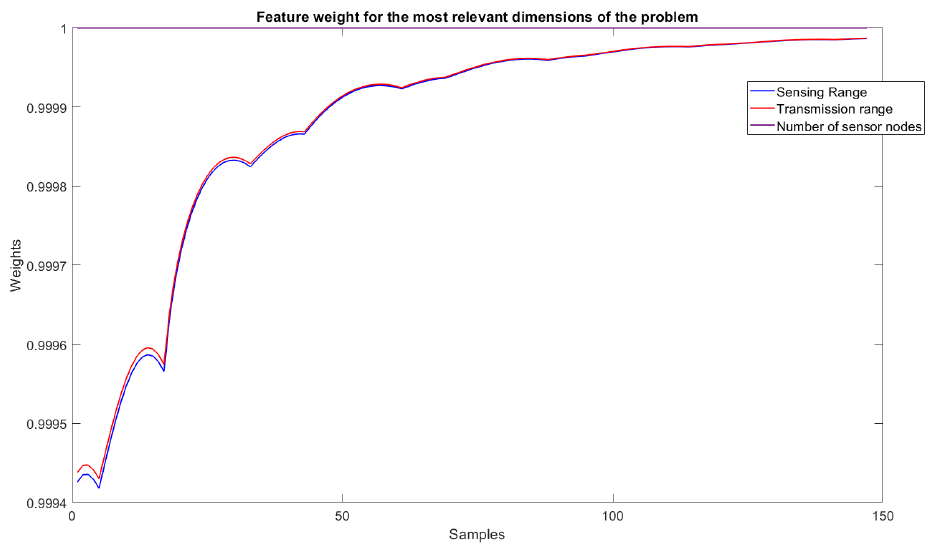
Figure 7. Result in trend lines for the evaluation of the k-barriers prediction (best